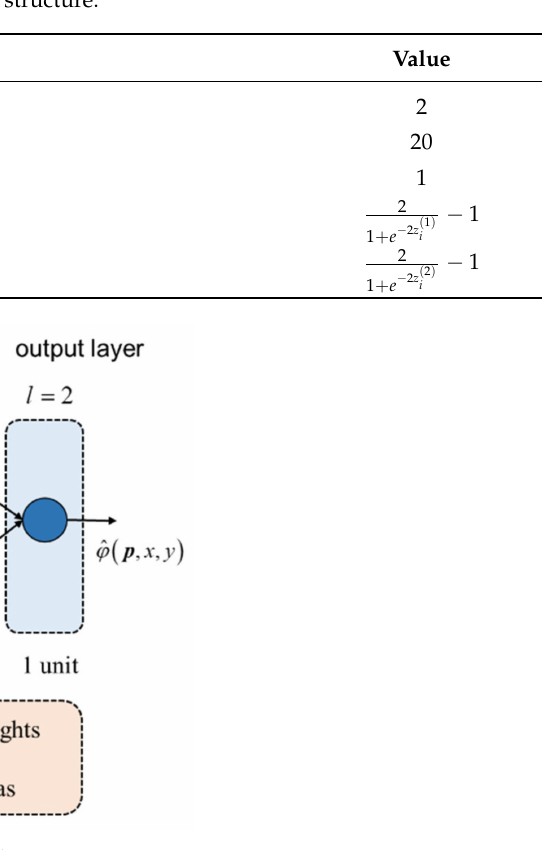
Figure 9. Structure diagram of the